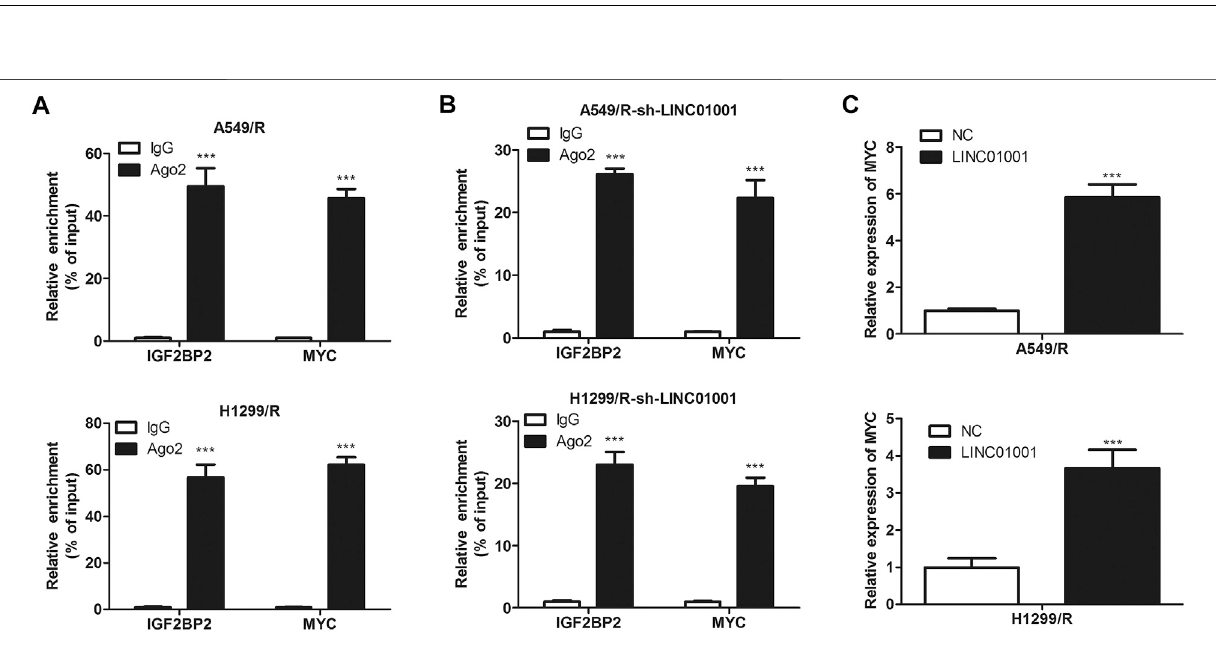
Frontiers in Pharmacology |